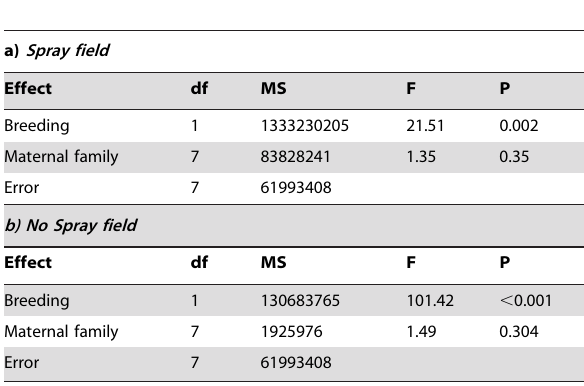
Table 3. Variance analysis for seed production per genet in year 2.